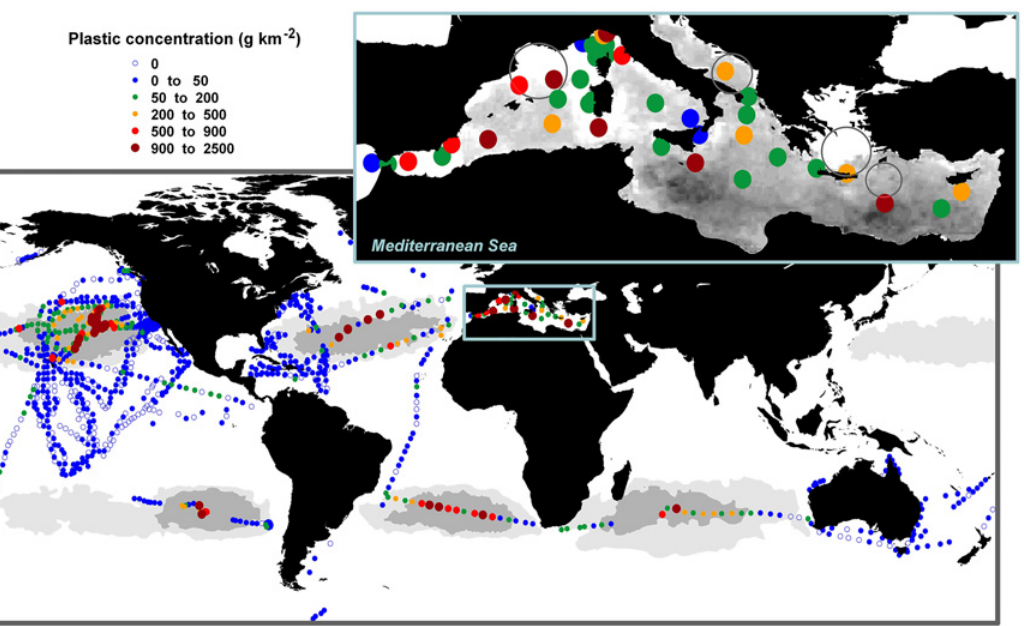
Fig 2. Concentrations of plastic debris in surface waters of the Mediterranean Sea at basin scale (zoomed in the top right corner inset), and compared to the plastic concentrations reported for the global ocean. Gray-scale base map in the Mediterranean basin shows the relative surface plastic concentrations predicted by numerical modeling [8]. Darker areas are predicted to have higher concentrations. Major areas of deep-water formation in the Mediterranean are also shown with black circles [24]. In the global map, dark and light gray areas represent inner and outer accumulation zones, respectively, modeled for the five subtropical gyres; white oceanic areas represent non-accumulation zones [7]. Mediterranean map compiles data from the present study and from ref. [20, 21], while open-ocean map compiles measurements of plastic concentrations from ref. [1 – 5, 10, 11]. Outside the inner accumulation zones, the open-ocean also includes concentrations reported without correction by wind effect (see details in ref. [5]).